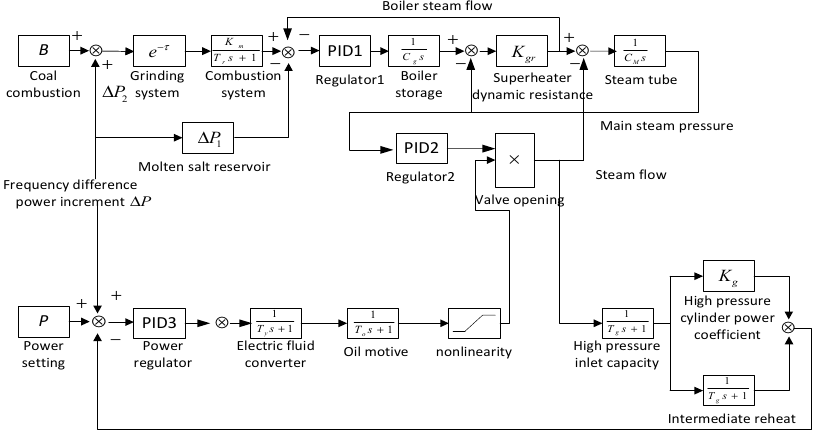
Figure 2. The steam heating and melting salt reservoir heat peak system coordination control model.